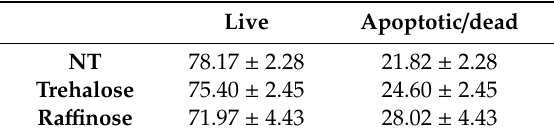
Table 2. Cell viability and apoptotic rate of Caco-2 cells treated with trehalose and raffinose (100 mM). The Caco-2 cells monolayer was treated with saccharides for 24 h and then analyzed through Annexin V cytofluorimetric analysis using a Muse ® Cell Analyzer (Merck). The percentage values obtained are reported as mean ± SE. The experiments were performed in triplicate. Cytofluorimetric plots are reported in Figure S6 (Supplementary Materials).